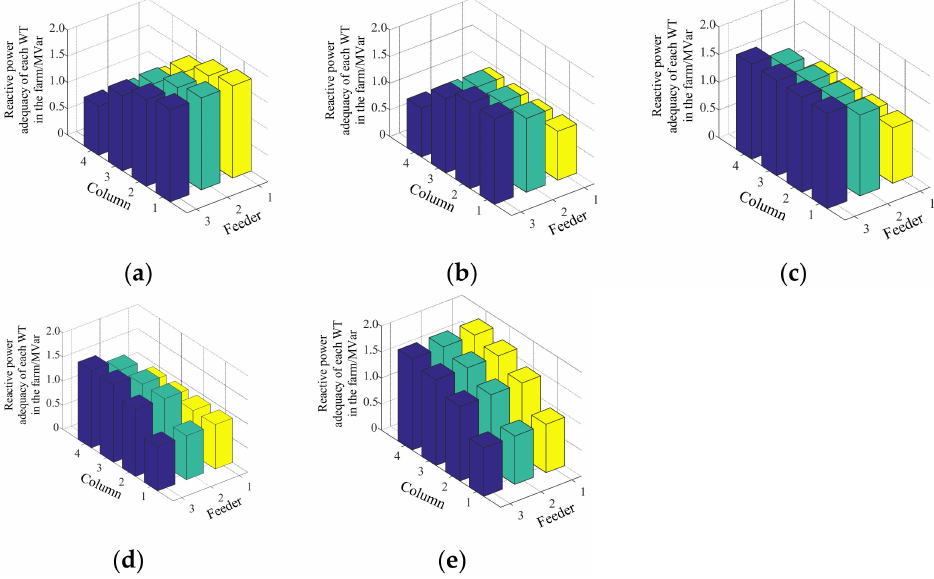
Figure 9. ( a ) 0 ◦ ; ( b ) − 45 ◦ ; ( c ) − 90 ◦ ; ( d ) − 135 ◦ ; ( e ) 180 ◦ . The simulation diagram of wake effect on reactive power adequacy of wind